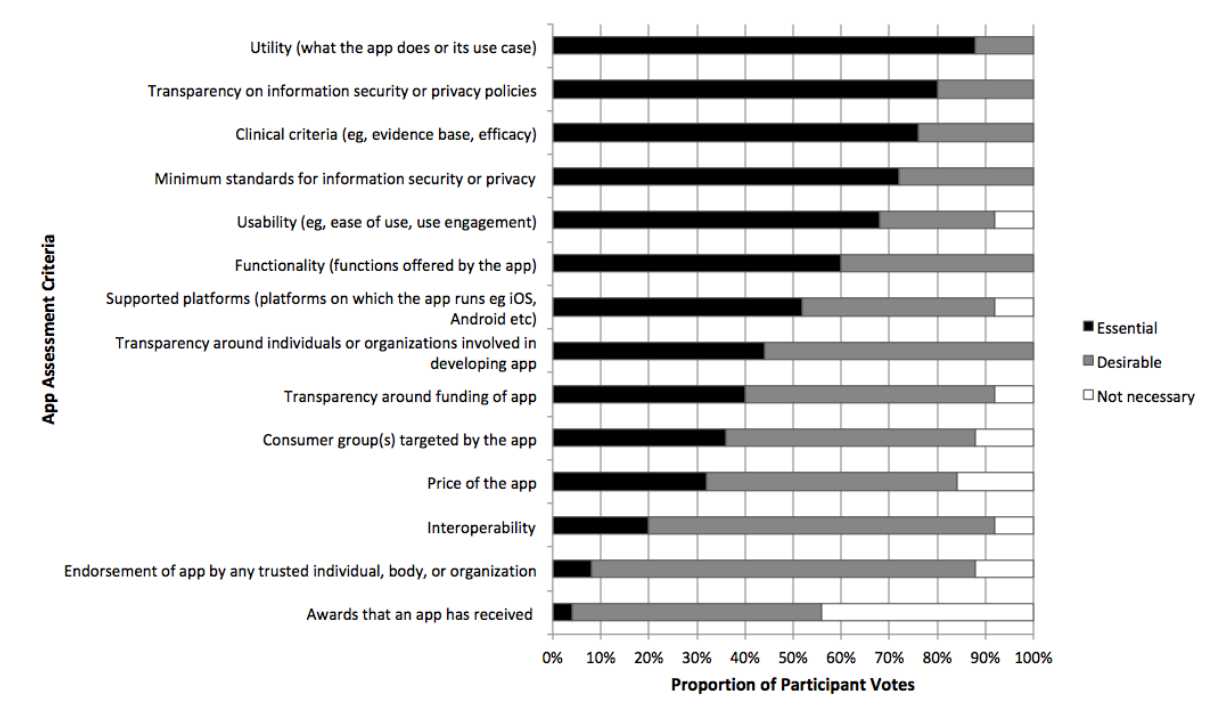
Figure 3. Round 1 rating of criteria for an e-mental health evaluation